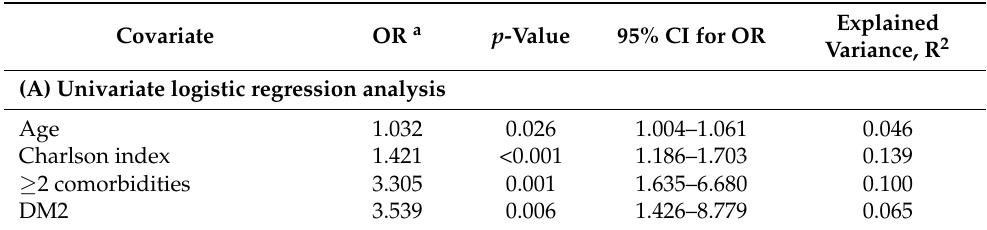
Table 2. Risk factors associated with impaired lung function at 12 months for the bivariate and multivariate